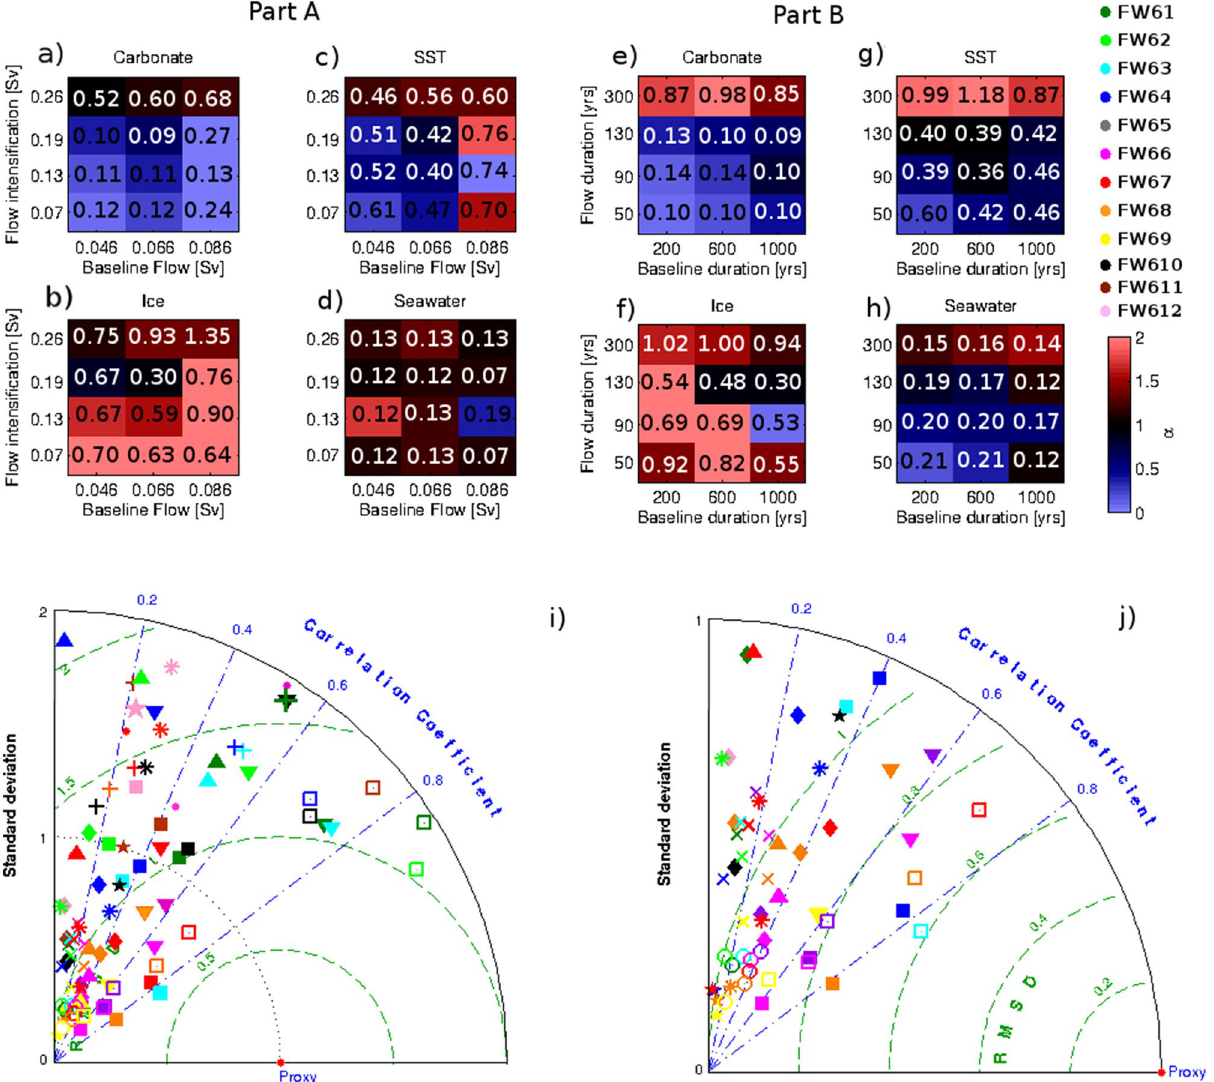
Figure 2. Analysis of simulations in Table 1—Parts A and B. ( a ) to ( h ) are the slope and RMSE values for each experiment. Plots ( a – d ) are for experiments in part A, while plots ( e – h ) are for experiments in part B. The colour of the squares represents the slopes according to the color bar, and RMSE values are indicated in the center of each cell. ( i ) Taylor diagram for comparison between proxy and simulated time series of δ 18 O anomalies: GISP ice core (filled square), Rapid Core δ 18 O c in G. inflata (filled rhombus) and G . bulloides (plus) , Gardar Drift core δ 18 O c for G . bulloides (filled circle), Florida Strait core δ 18 O c for G. rube r (X), Gulf core δ 18 O c for G. ruber (star), Rapid Core δ 18 O sw in G. inflata (asterisk) and G . bulloides (filled triangle) , Gardar Drift core δ 18 O sw (filled inverted triangle), Florida Strait core δ 18 O sw (open circle), and δ 18 O sw in Labrador Sea core (open square). The colors represent different simulations. Taylor diagram ( j ) is the same as ( i ), but zoomed in closer to the 0. Standard deviations are normalized by the core value, while RMSE is the Taylor diagram are statistically significant (p < 0.05, n > 1000—Fig. 2i,j). The highest correlations for δ 18 O sw are for the Labrador Sea cores and simulations FW61 (0.84), FW62 (0.88), and FW63 (0.83). In the Gardar Drift time series of δ 18 O sw , FW61 and FW63 have the strongest correlation with the core (both 0.75), but the lowest RMSE value is achieved by FW66 (0.76‰). FW61 and FW63 also have the highest positive correlations for δ 18 O sw at the RAPiD core based on G. bulloides (0.47 and 0.48 respectively), for G. bulloides δ 18 O c in the RAPiD core (0.54 for FW61). According to the Diebold-Mariano test, RMSEs for FW61, FW63 and FW66 in δ 18 O c and δ 18 O sw are significantly different with confidence varying from 85 to 99%. The exceptions are δ 18 O c errors between FW61 and FW63, which are equal with 90% confidence. These results suggest that errors in δ 18 O sw for simulations FW61, FW63 and FW66 are statistically different and possibly not random. Simulations FW61, FW63 and FW66 are the ones that best reproduce δ 18 O mean anomalies in most proxies and locations and have the best correlations and RMSEs for the whole time series. As a last step, and in an effort to determine the most